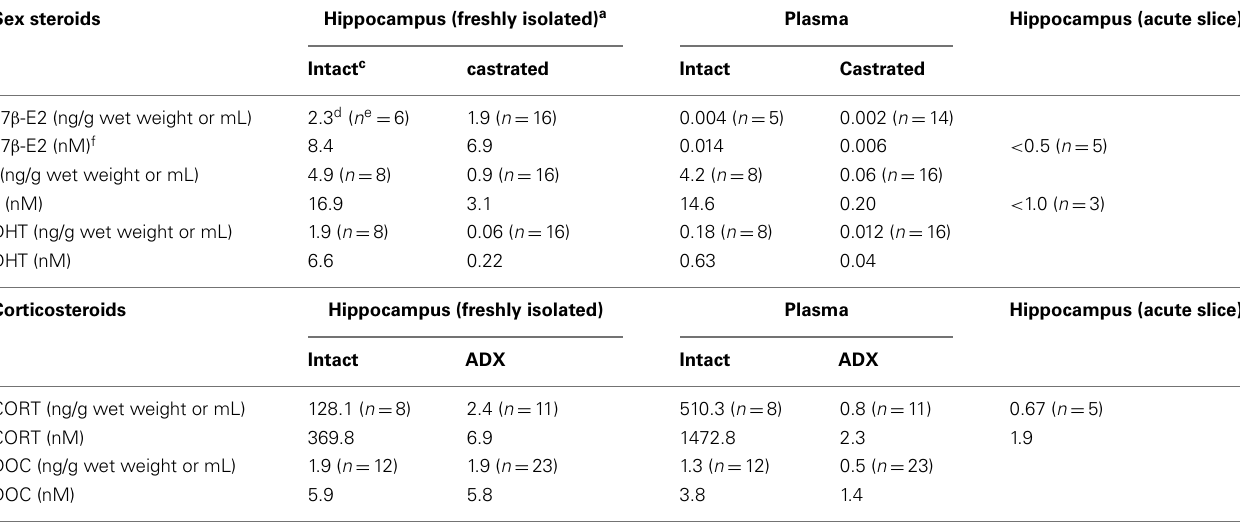
Table 1 | Mass-spectrometric analysis of the concentration of steroids in the hippocampus and plasma of adult rats. Sex